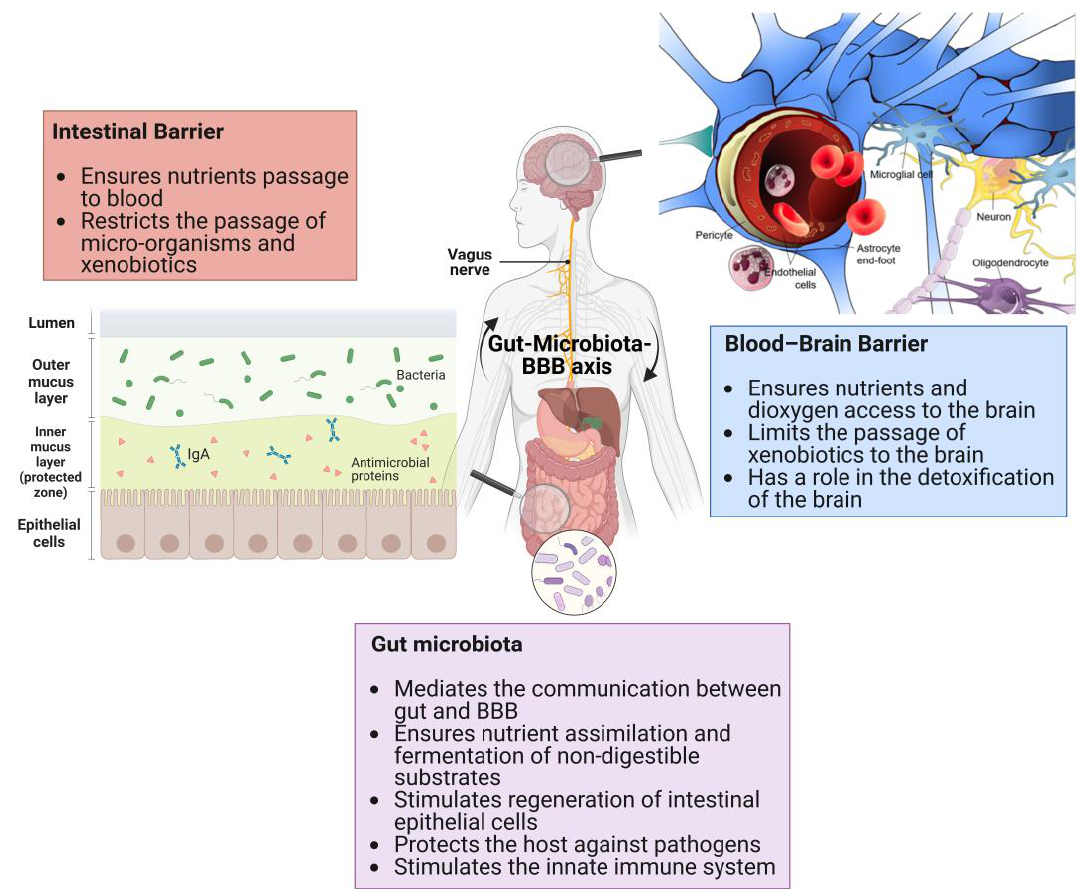
Figure 1. Gut-Microbiota – Blood – Brain Barrier Axis.